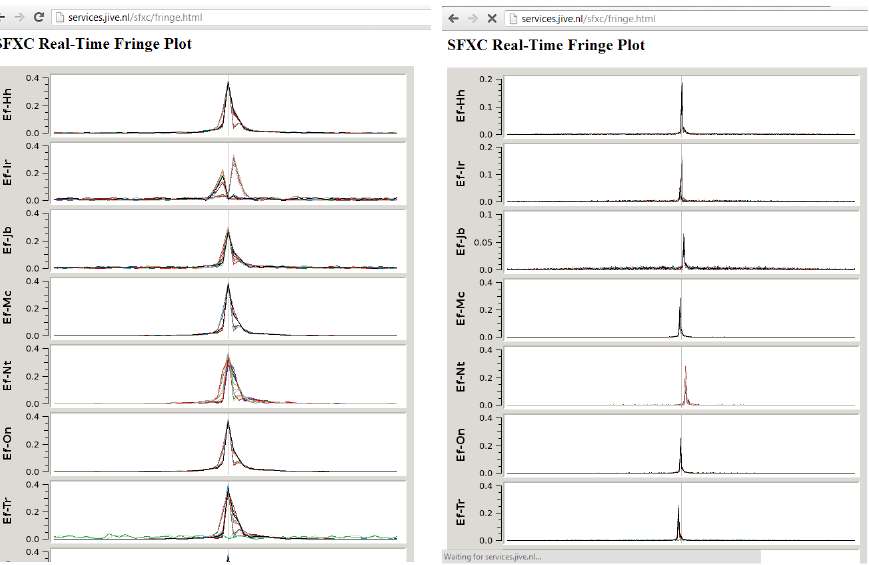
Fig. 4. Two snapshots of the real-time fringe plots calculated with SFXC correlator in JIVE during the EG069C experiment. The second snapshot (from the top) displays the results of the correlation functions of the baseline Effelsberg – Irbene (Ef–Ir). From